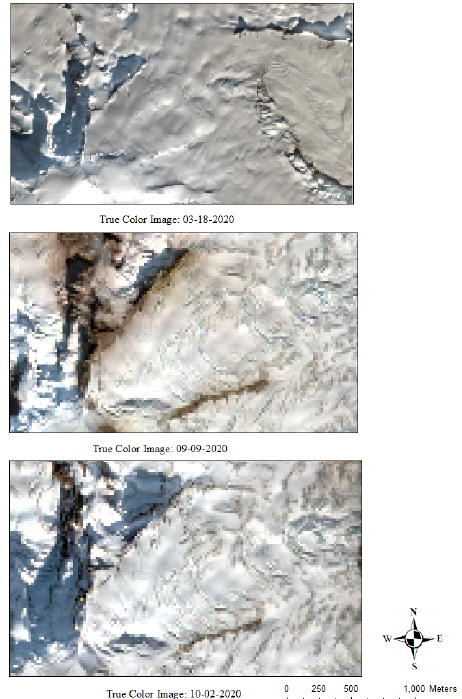
Figure 5: True Color Images (Closer Inspection)